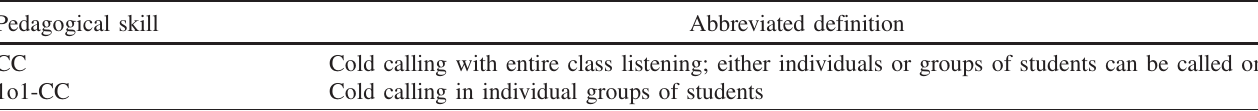
TABLE IV. Definitions for codes with respect to target pedagogical skills. Pedagogical